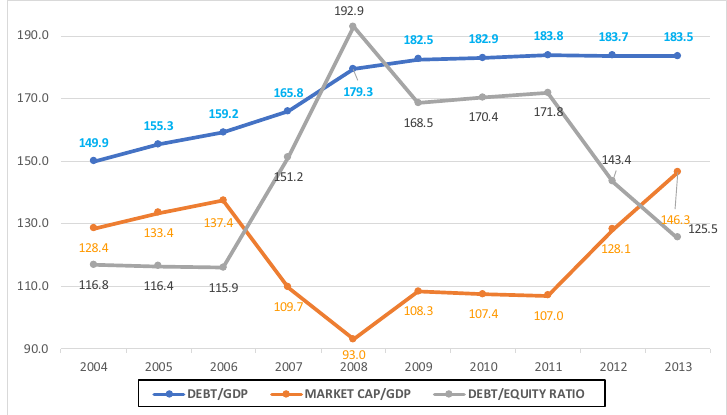
Figure 1. Debt-equity